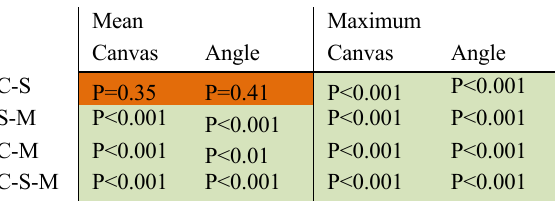
Table 3: Results of the ANOVA calculated to examine H0: “There is no significant difference in the maximum/mean vis- ual angle over which the different types of changes are per- ceived.” (P≥0.05 is considered significant)